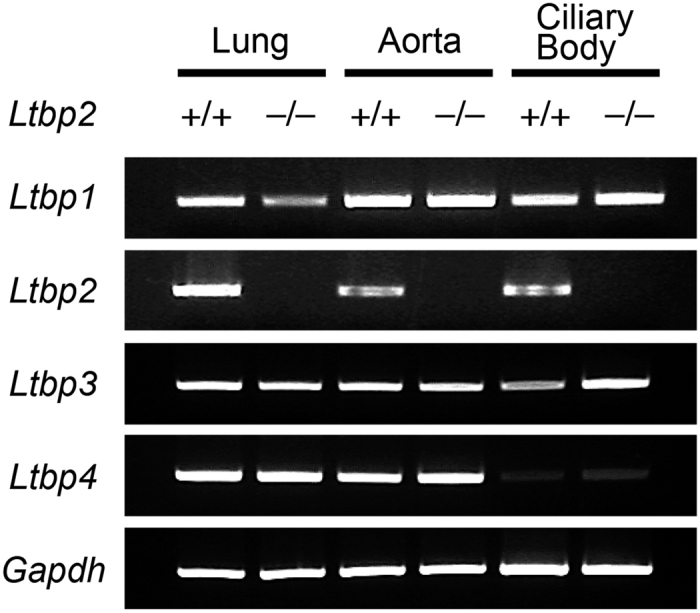
Expression of genes of the LTBP family in mouse tissues.Gene expression of Ltbp1, 2, 3 and 4 and Gapdh in ciliary bodies, aorta and lung tissues from wild type (+/+) and Ltbp2−/− (−/−) mice was analyzed using RT-PCR. Expression of Ltbp4 was hardly detected in ciliary body tissues from either wild type or Ltbp2−/− mice.